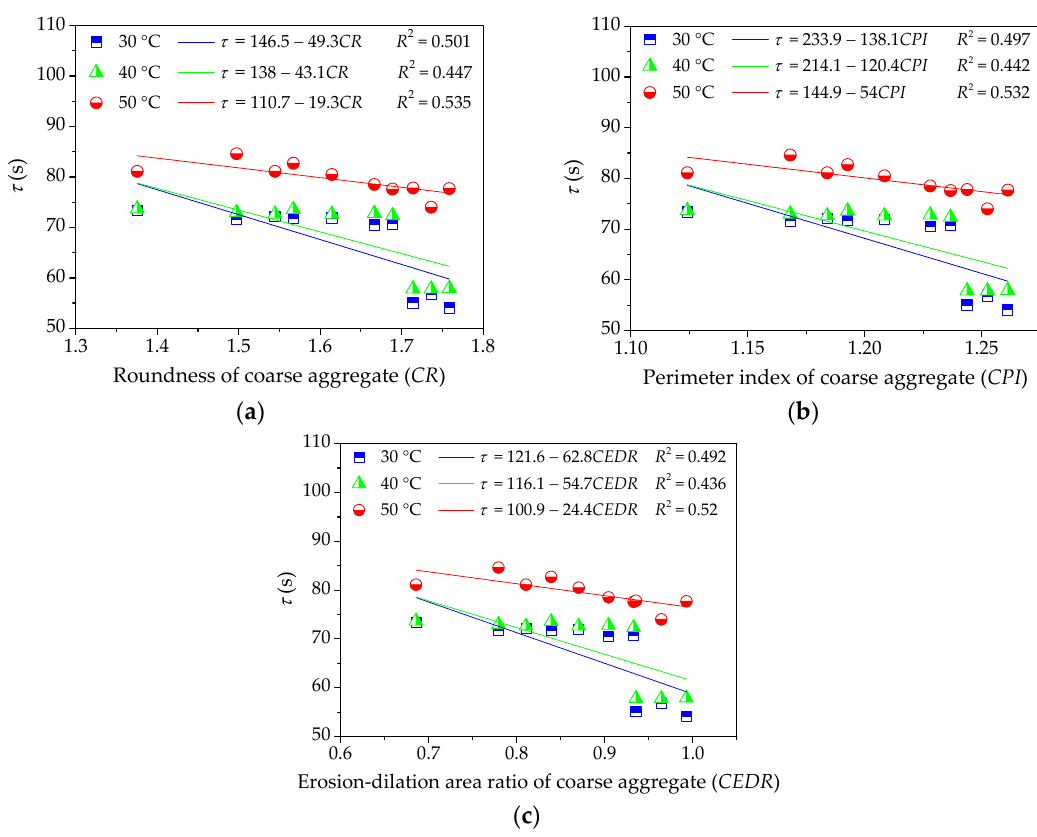
Figure 13. Influences of coarse aggregate morphological characteristics of on τ of asphalt mixture: ( a ) Shape ( CR ); ( b ) Angularity ( CPI ); and, ( c ) Texture ( CEDR ).